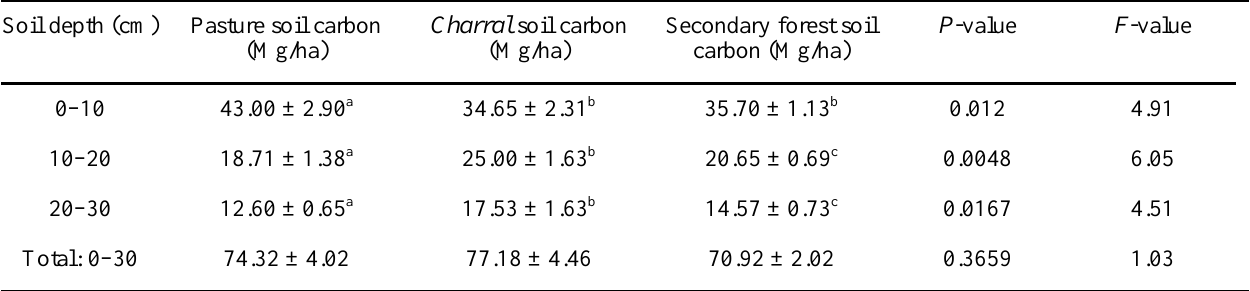
Table 3 . Means of mineral soil carbon storage ± one standard error across all land-use types and soil depths. Reported P -values and F -values were derived from individual ANOVAs performed for each soil depth. For each analysis, the numerator degrees of freedom were 2 and denominator degrees of freedom were 43. Different superscripted letters represent significant differences among categories, as determined by means